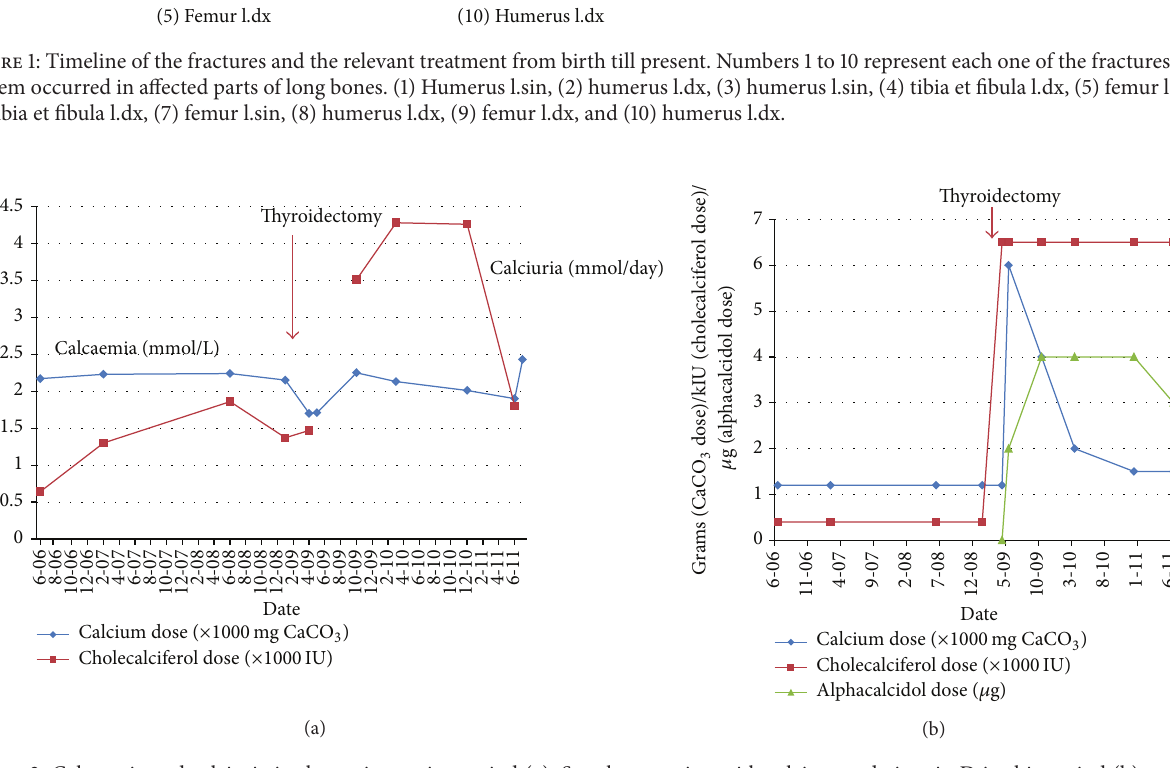
the level of patient’s compliance in the use of the